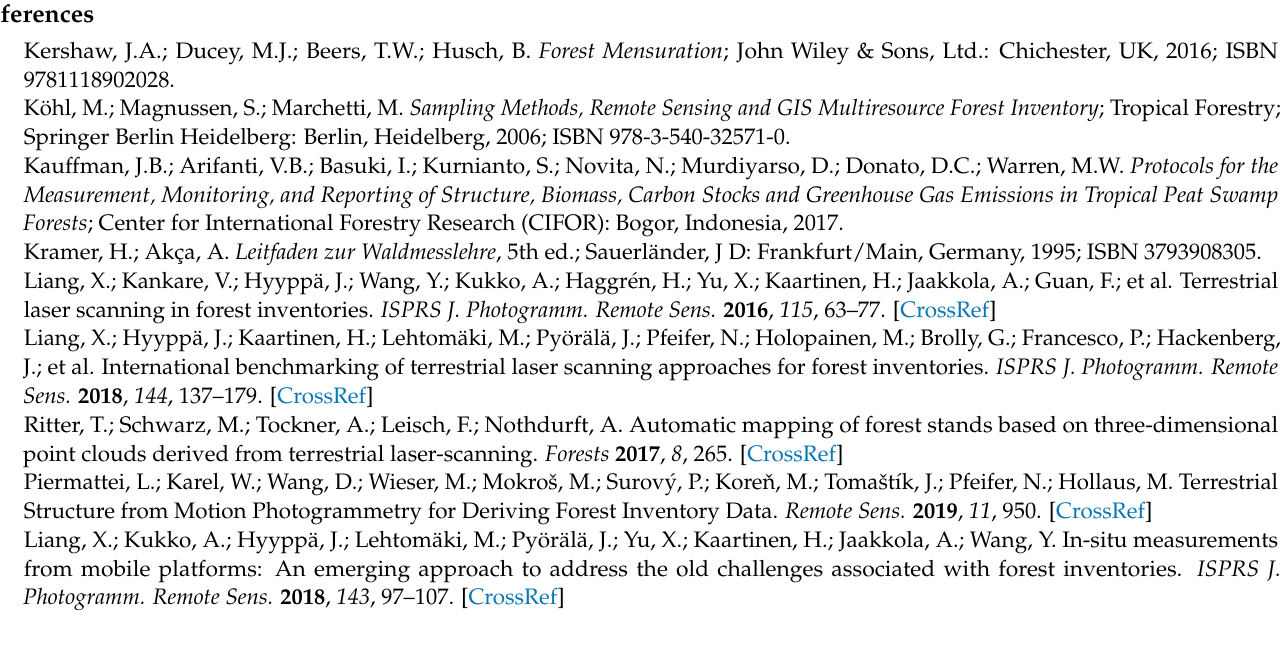
Figure A2. Overview of three object cross-sections, including the fitted diameters, deviations, and standard deviations of the residuals. The solid red and black circles indicate the diameter d gam and d circ2 , respectively. The solid green circle indicates the diameter of the reference circle.